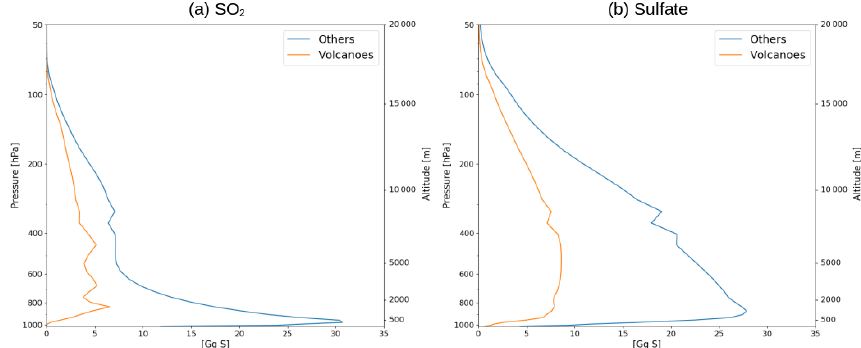
Figure 8. The 2013 annual global mean vertical profile for (a) SO 2 and (b) sulfate aerosols from volcanic and other sources.